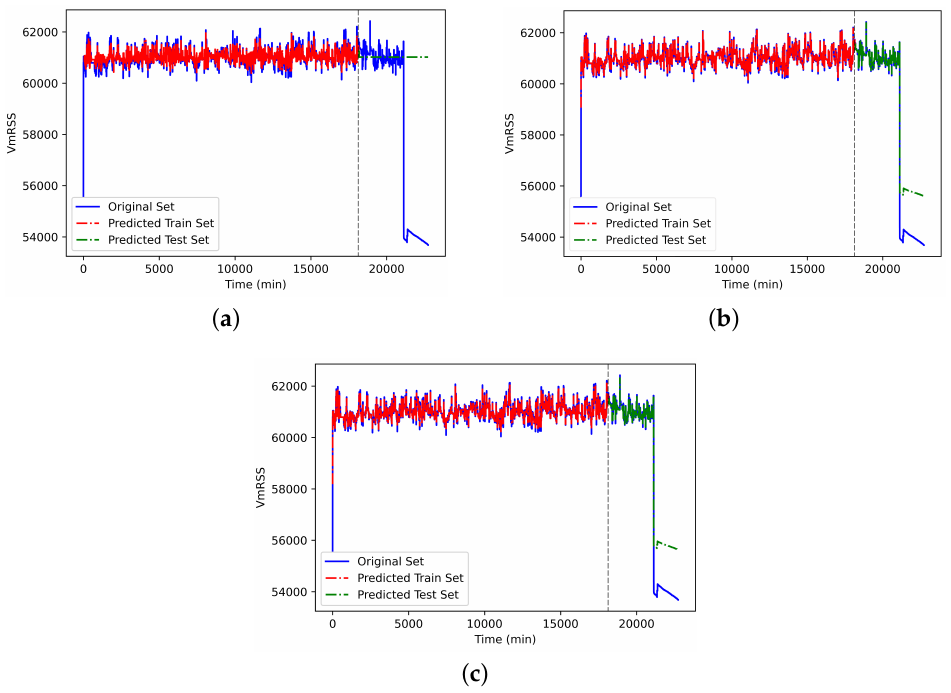
Figure 6. Graphics for data type “VmRSS”: ( a ) moving average; ( b ) Vanilla-LSTM; ( c ) proposed (moving average +